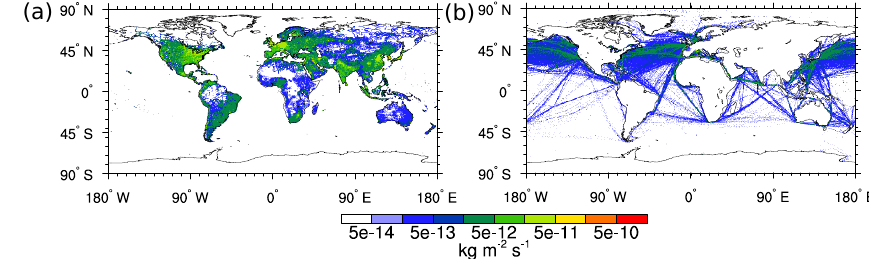
Figure 1. Average (2006–2010) flux of NO x emissions (in kg ( N ) m − 2 s − 1 ) from (a) land transport and (b) shipping.